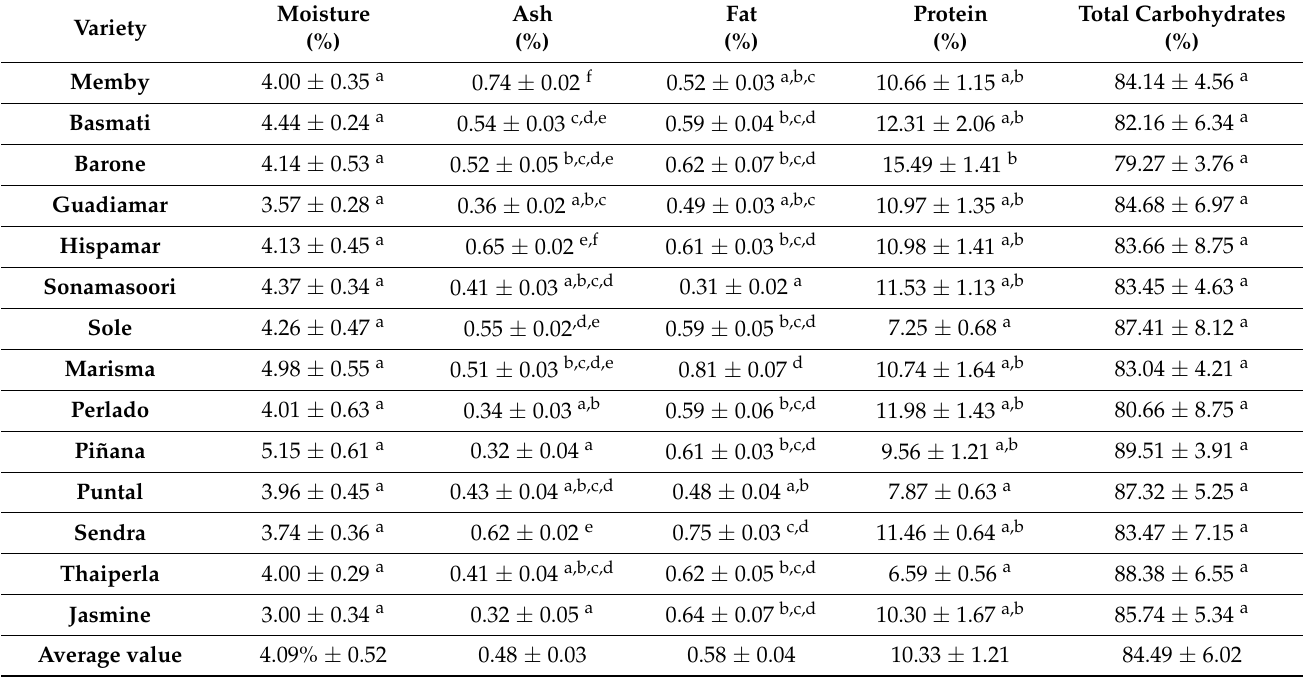
Different letters in the same row indicate significant differences by ANOVA test ( p < 0.05).